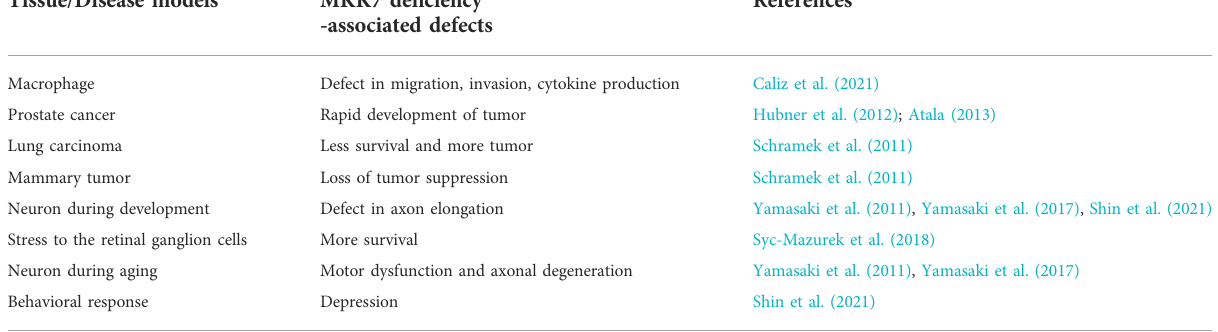
TABLE 1 MKK7 de fi ciency -associated defects in